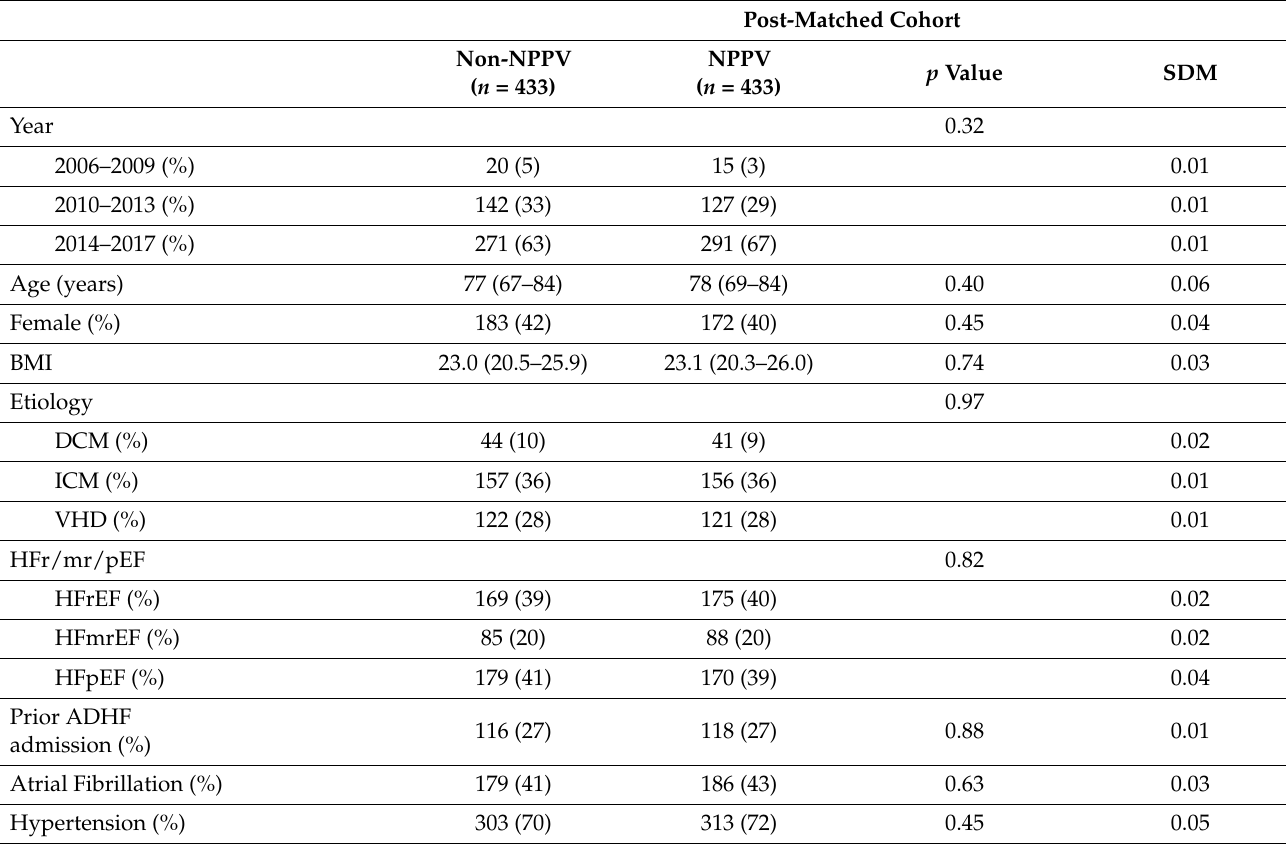
Table 2. Baseline characteristics according to non-invasive positive pressure ventilation use in the post-matched cohort. Post-Matched